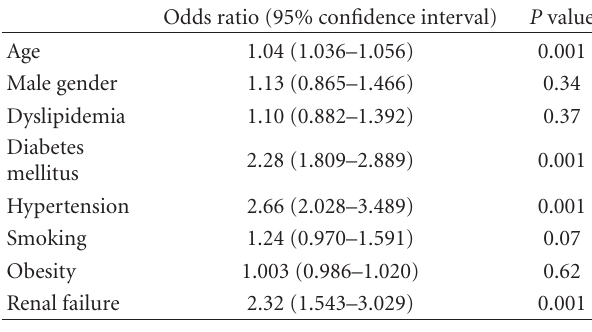
Table 3: Multivariate logistic regression analysis for clinical pre- dictors of polyvascular disease in patients presenting with acute coronary syndrome.